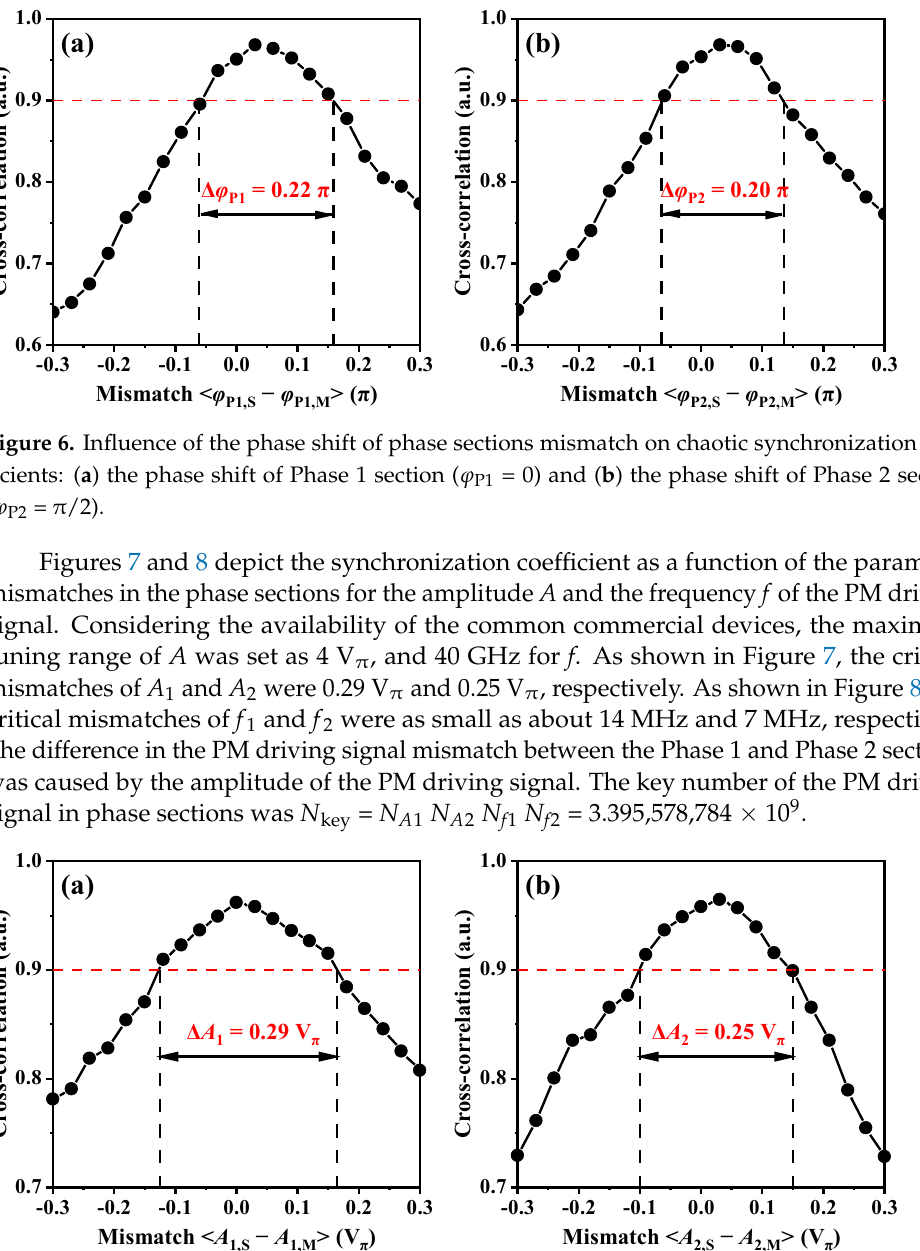
Figure 7. Influence of PM driving signal in the phase sections mismatch on chaotic synchronization coefficients: ( a ) the amplitude index ( A 1 = 0.5 V π ) in the Phase 1 section and ( b ) the amplitude index ( A 2 = V π ) in the Phase 2 section.